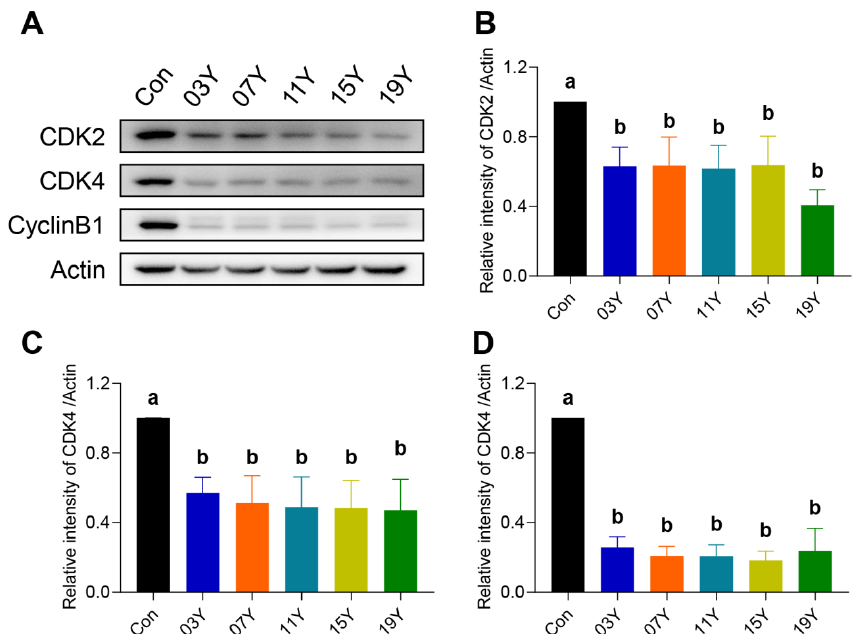
Figure 4. Th tea extract inhibited the expression of cell-cycle-related proteins. ( A ). HT-29 cells were treated with 0.2 mg/mL extract of different tea samples 03Y , 07Y , 11Y , 15Y and 19Y for 48 h, and then CDK2, CDK4 and CylinB1 expressions were detected by Western blotting. ( B – D ). Relative quantification of CDK2, CDK4 and CylinB1 protein levels in each group was shown, with actin as a reference. One-way ANOVA analysis was performed between the treatments of multiple tea samples. The different lowercase letters (a and b) in the same group show the significant differences at p < 0.05 level.